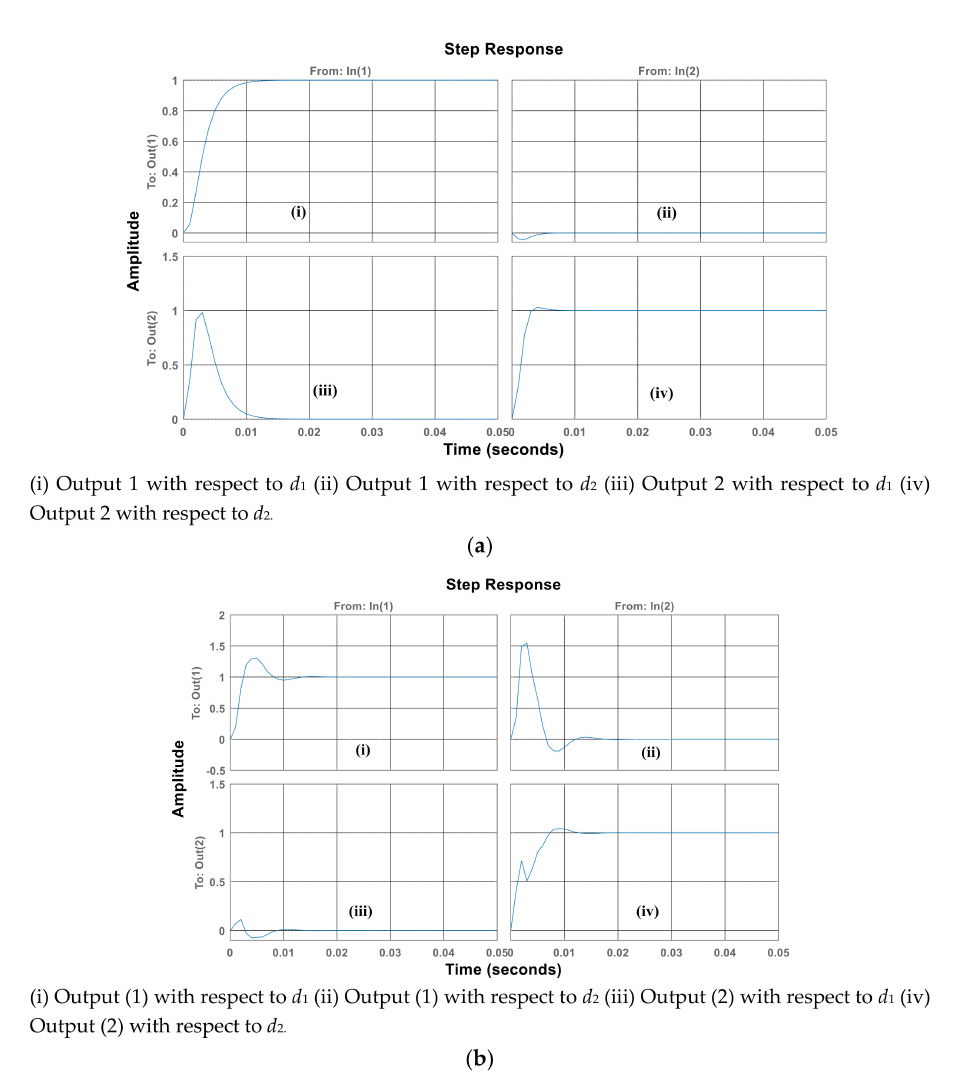
Figure 7. Response of unit step function ( a ) Multivariable PID – SIDO converter ( b ) Multivariable PID–DIDO converter.